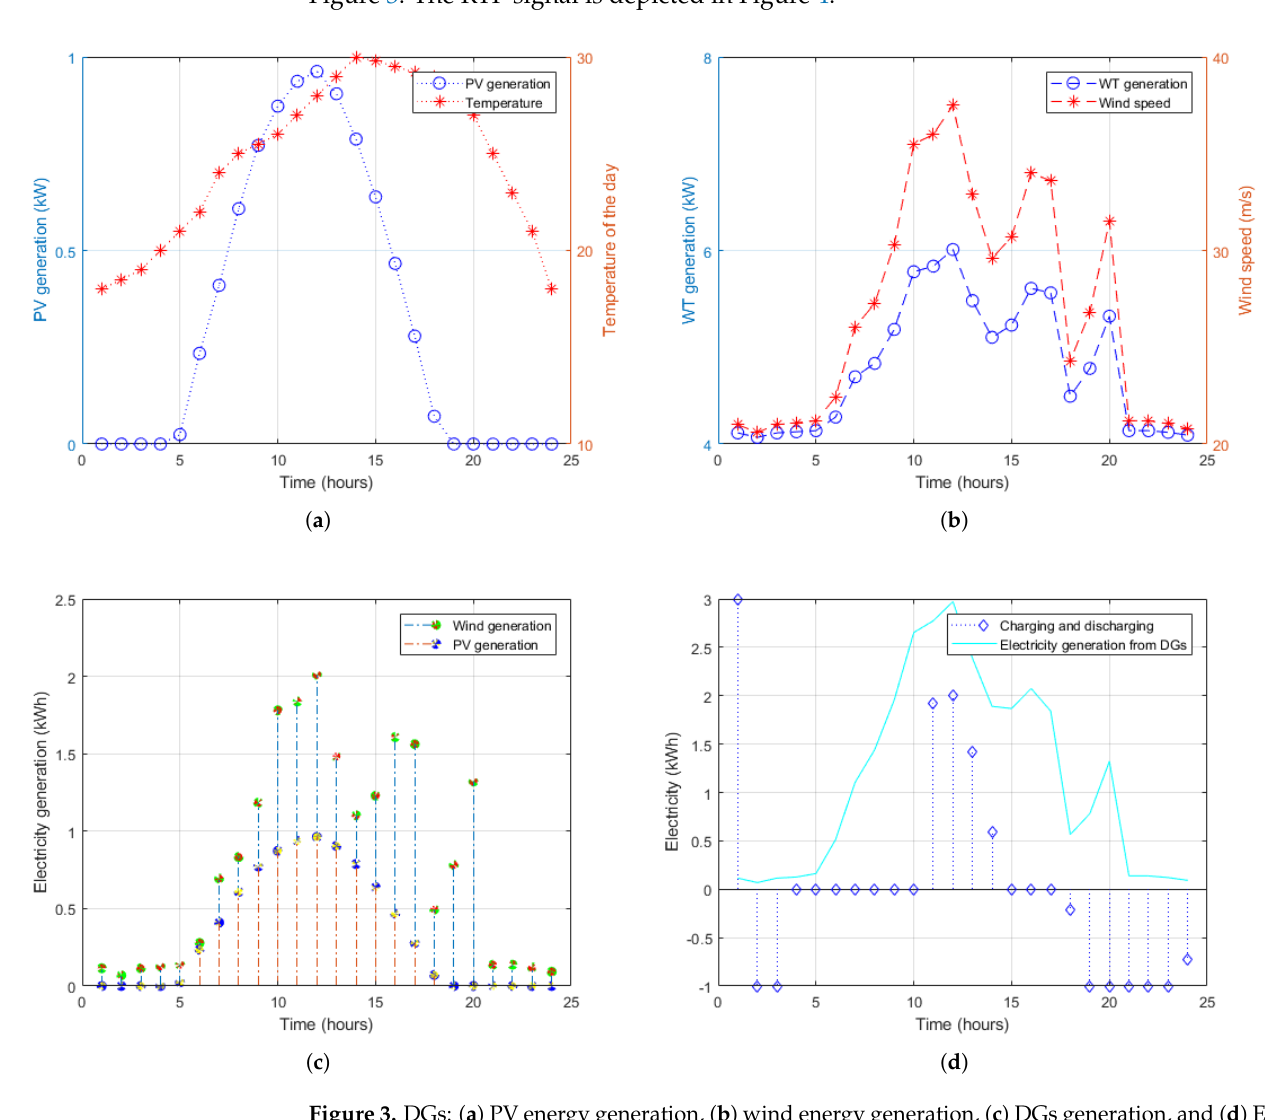
Figure 3. DGs: ( a ) PV energy generation, ( b ) wind energy generation, ( c ) DGs generation, and ( d ) EVs charging/discharging with